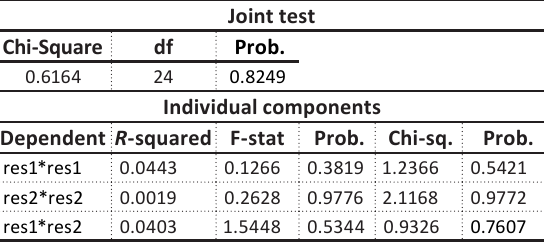
Table 6. VAR residual heteroskedasticity test